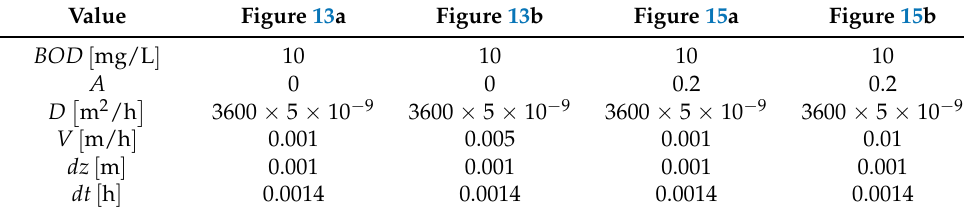
Figure 13. BOD distribution including diffusion for V = 0.001 ( a ) V = 0.005 ( b ). It is evident that the initial pollution introduced into the water persists over a long period of time at an appropriate length (cf. Figure 8a,b). In the initial moments of time at a given length, the BOD concentration is high, after which it spreads accordingly over the given area. Depending on the speed of the river, the distribution of pollutants in the river at the same moments of time, along the same length, is different: see Figure 14. Table 5. The initial values adopted in the simulation studies for the cases shown in Figures 13 and